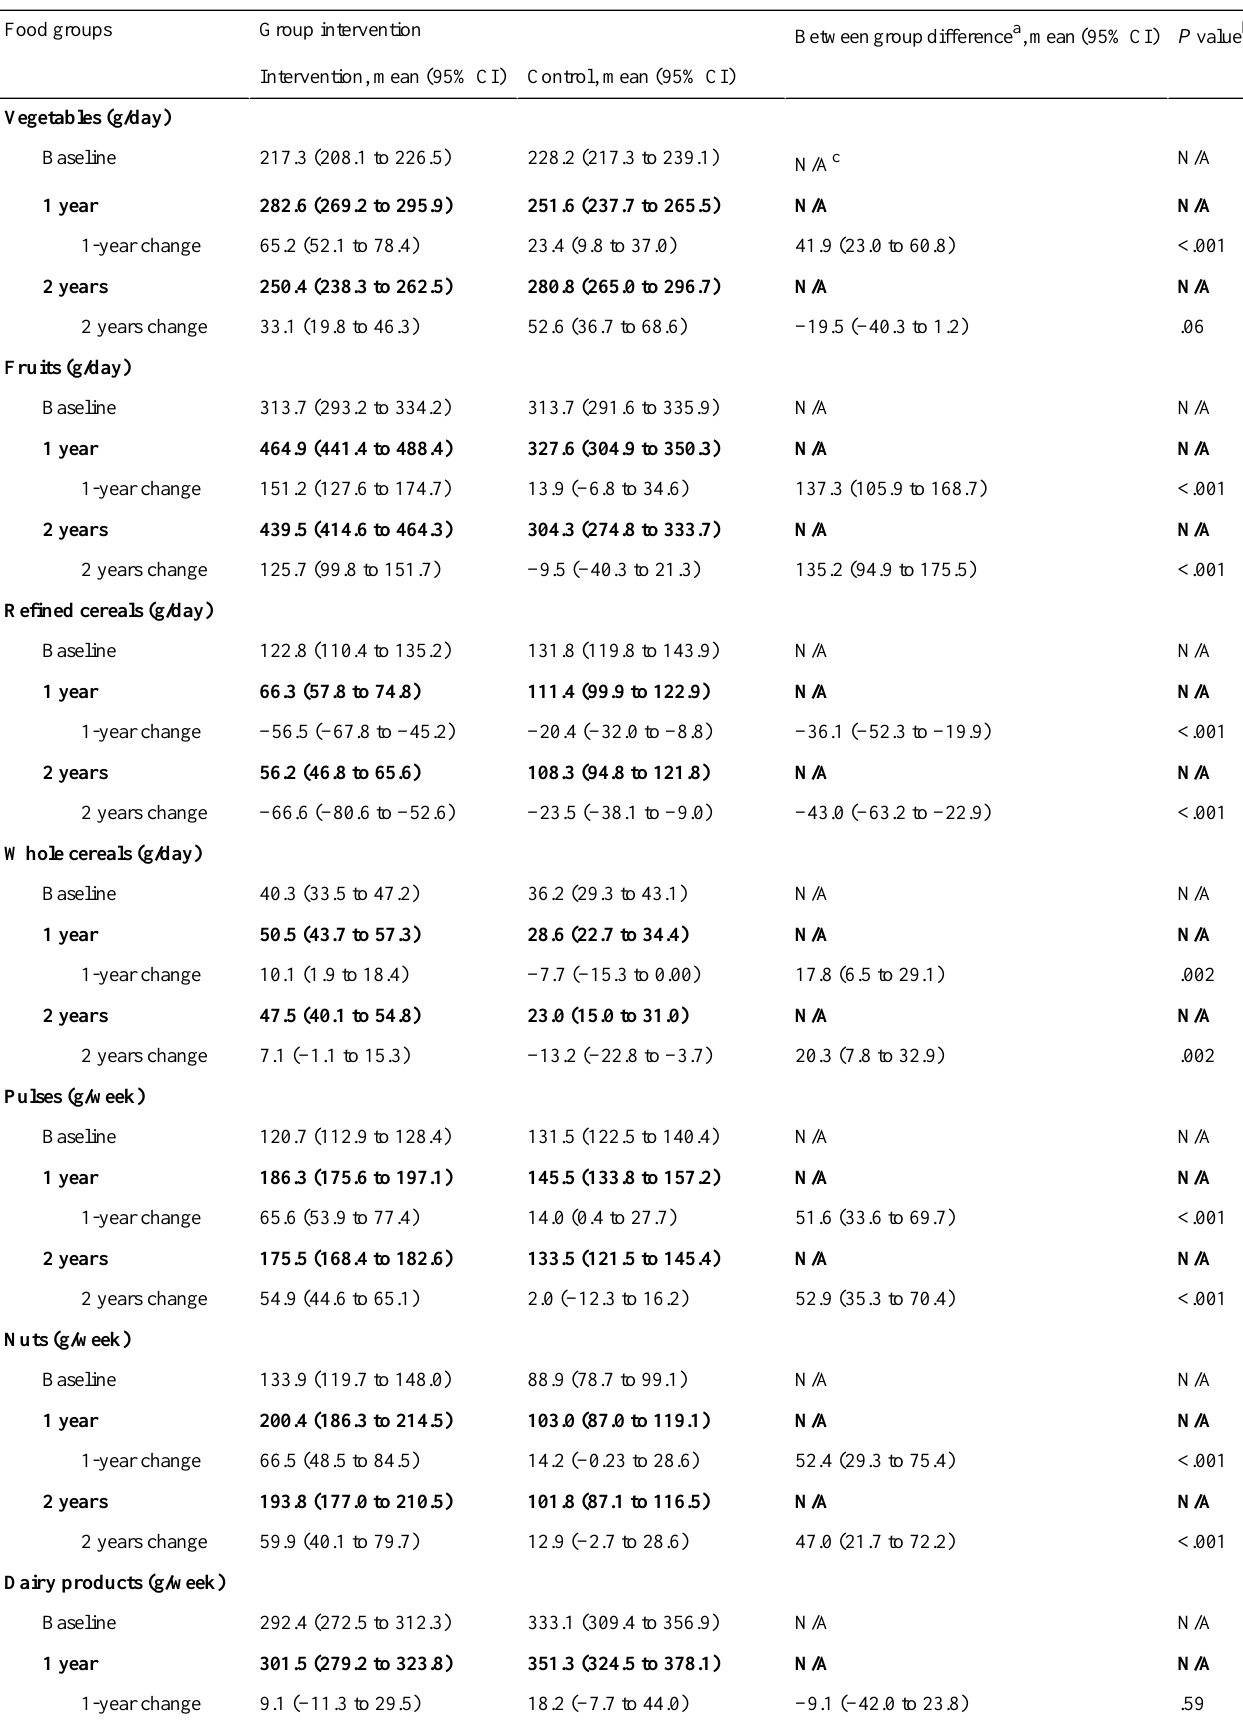
Table 2. Baseline food groups consumption and changes by randomized treatment group at 12- and 24-month follow-up visits of participants in the prevention of recurrent arrythmias with Mediterranean diet